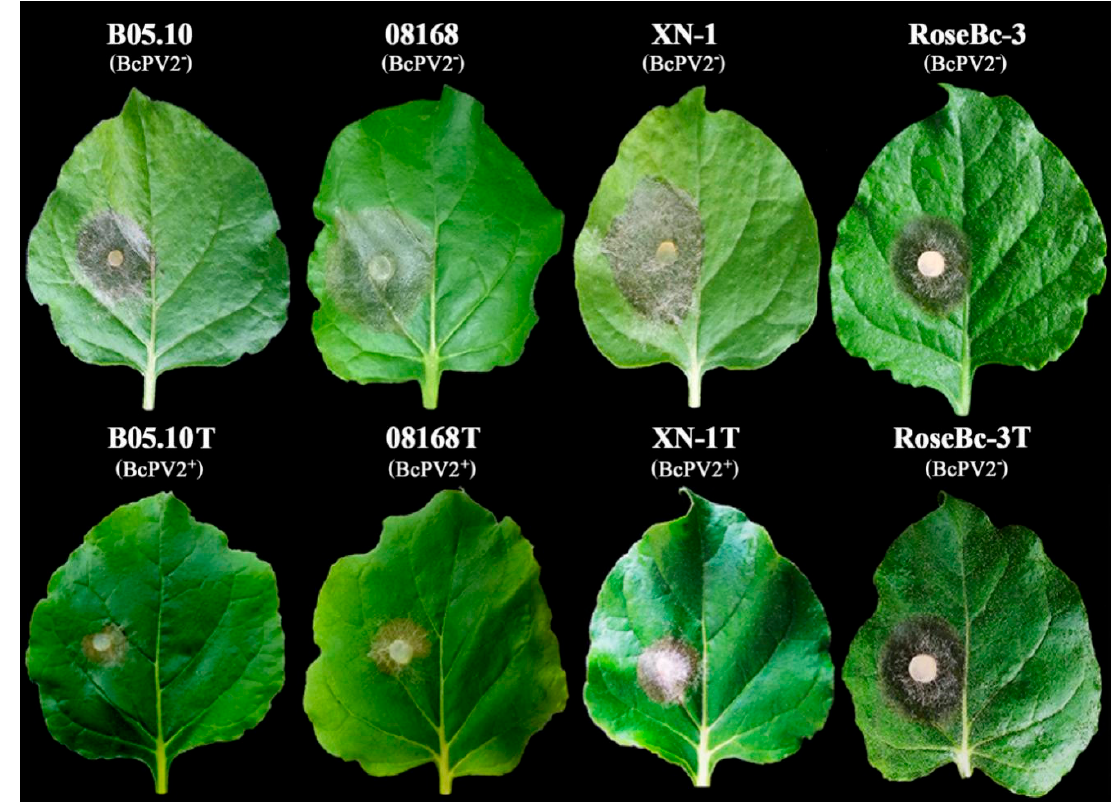
Figure 10. Pathogenicity of different isolates of Botrytis cinerea on detached leaves of Nicotiana benthamiana (20 °C, 72 h). Note smaller leaf lesion size caused by B05.10T, 08168T, and XN-1T than that caused by B05.10, 08168 and XN-1, whereas similar leaf lesion size caused by RoseBc-3T and RoseBc-3. BcPV + = infected by BcPV2; BcPV2 − = not infected by BcPV2.